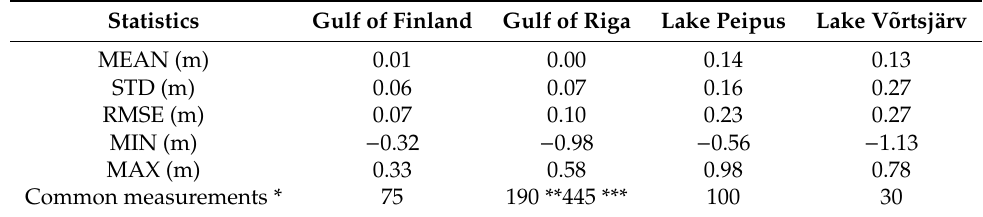
Table 5. Statistics of di ff erences between the sea surface heights derived from altimetry ( SSH SA ) and geoid-based sea surface height ( SSH TG ) according to the Equation